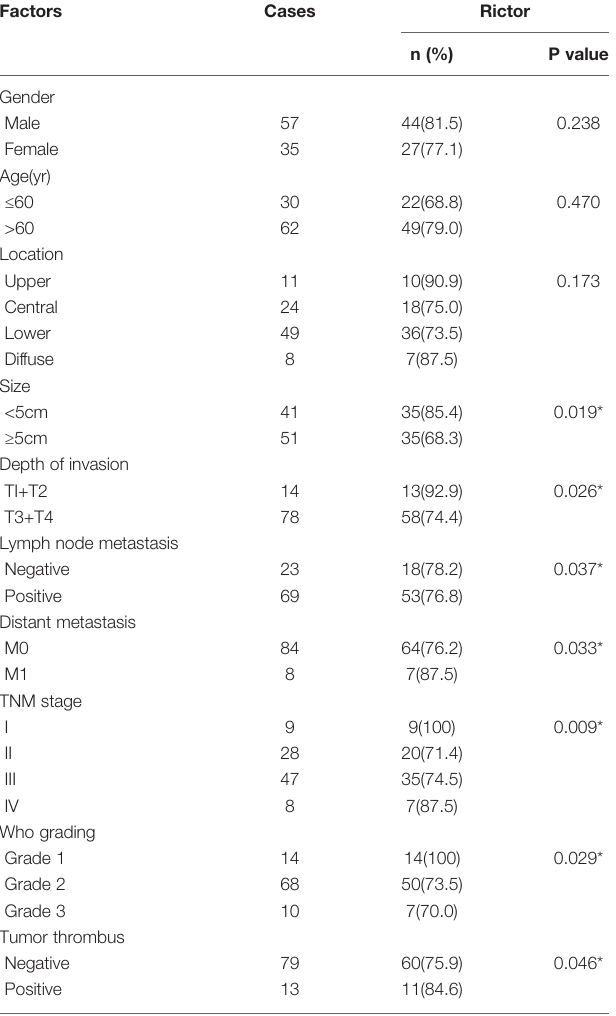
TABLE 1 | Correlation of Rictor expression with clinicopathological characteristics in 92 gastric cancer patients.